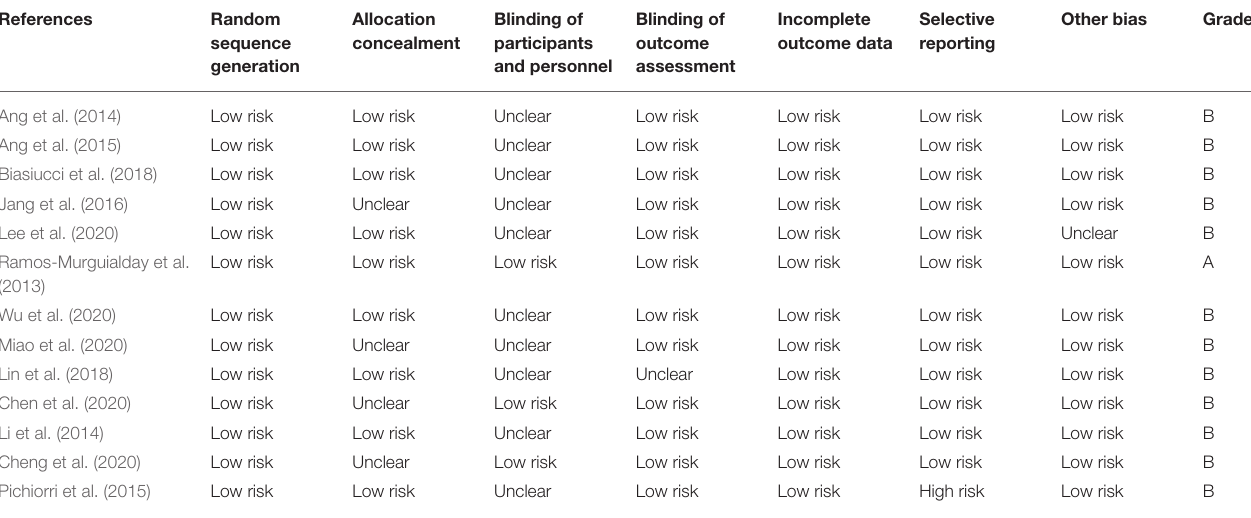
TABLE 2 | Methodological quality assessment of the